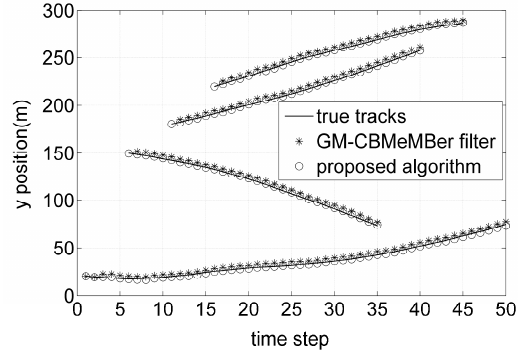
Figure 4. True target tracks and position estimations in y coordinate versus time.